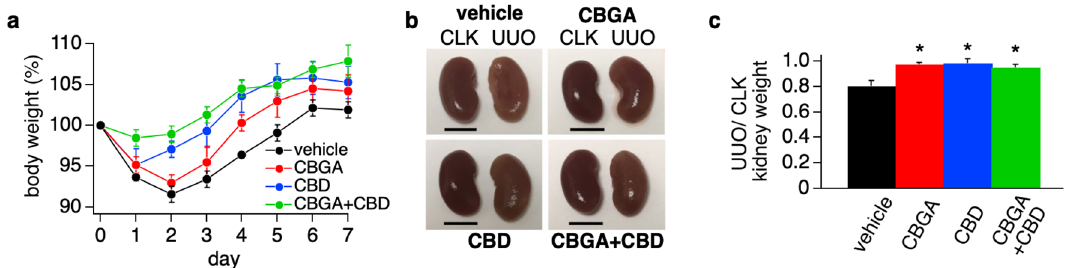
Figure 4. CBGA and CBD prevent kidney atrophy in the UUO mouse model. ( a ) Body weight of mice was measured daily before administration of CBGA (10 mg/kg, red circles), CBD (10 mg/kg, blue circles) and CBGA + CBD (each 10 mg/kg, green circles) from post-UUO surgery day 0 to day 6 (n = 5) and before sacrifice at day 7. The non-treatment group was injected daily with vehicle as a control (n = 4, black circles). Body weight of each day was normalized by the weight before UUO surgery, and the average is indicated. ( b ) Representative images of CLK (left in each picture) and UUO kidneys (right in each picture) isolated from UUO mice at day 7 after UUO surgery. Scale bars represent 5 mm. ( c ) The ratio of UUO kidney weight at day 7. Each UUO kidney weight was normalized by the weight of the corresponding CLK kidney, and the ratio is indicated. Black bar represents the vehicle treatment as a control group, red bar is CBGA treatment group, blue bar is CBD treatment group, and green bar represents CBGA + CBD treatment group. *p < 0.05 vs. vehicle treatment.